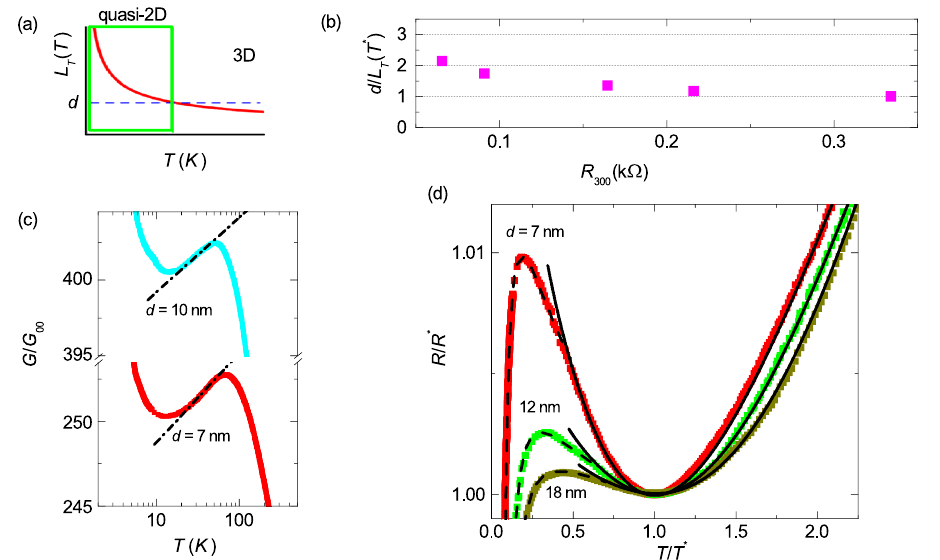
Figure 2. Dimensional crossover and quantum contributions fits. ( a ) A sketch of the temperature dependence of thermal coherence length ∝ L T 1/ (solid line). The rectangle confines the region where L T exceeds the T film thickness d (dashed line). ( b ) The ratio of the film thickness to thermal coherence length d / L T ( T * ) at the crossover temperature T * vs . resistance at room temperature R 300 . ( c ) The dependence R ( T ) from Fig. 1a replotted as a dimensionless conductance G / G 00 as function of the temperature in the logarithmic scale for samples d = 10 nm and d = 7 nm. Dash-dotted lines correspond to G / G 00 ∝ ln T . ( d ) The reduced resistance R / R * vs reduced temperature T / T * , where T * and R * are the temperature and resistance at the local minimum. Symbols stand for experimental data, solid lines are fits by Eqs (7) and (8). Note, that three samples with lowest T c did not show a R(T) minimum. Dashed lines are fits accounting for all the quantum contributions to conductivity (see Fig. 3a and the discussion in the